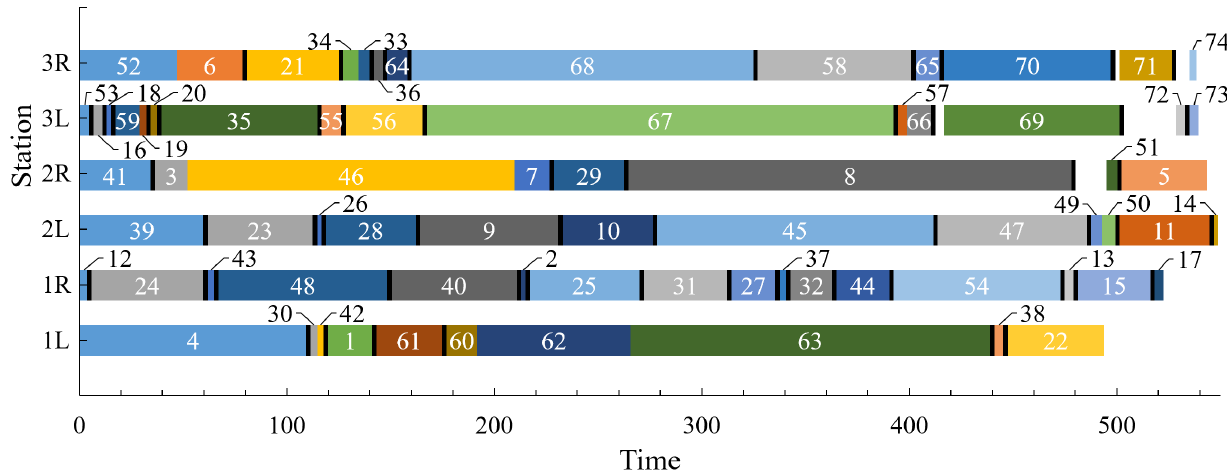
Figure 9. Gantt chart of disassembly scheme S 3 .